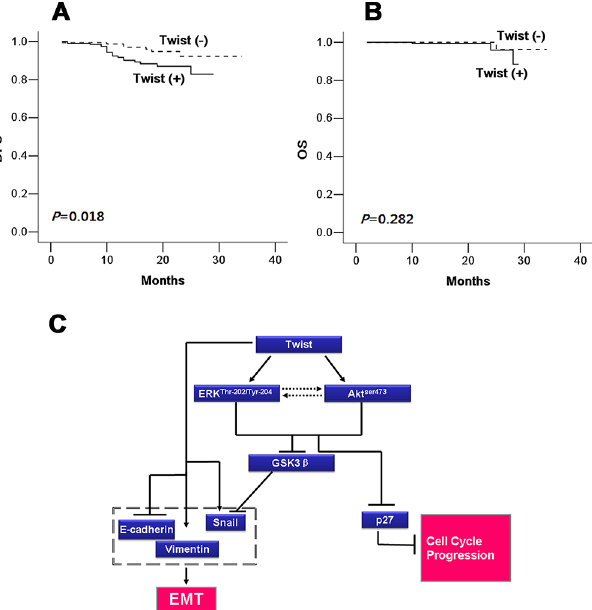
Fig 6. Twist expression predicts worse DFS and OS in patients with breast cancer by Kaplan-Meier analysis, and a schematic diagram of the proposed model. (A) The left side indicates DFS in the Twist (+) group was lower than that of Twist (-) group ( P = 0.018). (B) The right side demonstrates there was no difference in OS between Twist (+) and Twist (-) groups ( P = 0.282). Twist (+): Twist-positive group; Twist (-): Twist-negative group. (C) A schematic diagram of the proposed model. A proposed model to illustrate how Twist activates both Akt and ERK pathways through their phosphorylation, further down-regulates phsopho- GSK-3 β and p27, and in turn induces the expression of EMT marker properties associated with EMT. negative group (88.5% vs. 96.3%), but failed to meet statistical significance ( P = 0.282, Fig 6B, Table 4). Among all these clinicopathological features and biomarkers, only ER ( P = 0.047) and E-cadherin ( P = 0.042) were negative predictors for OS.